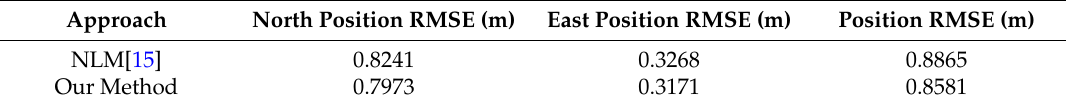
Table 3. Analysis of computational